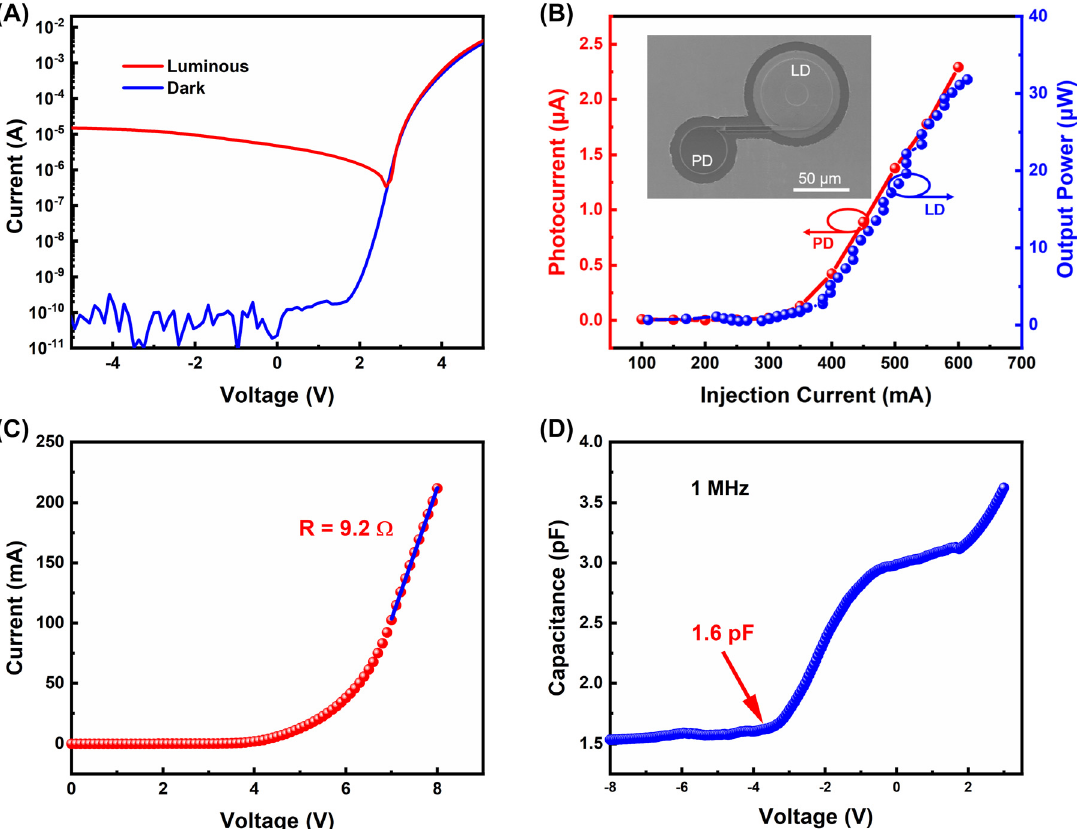
Figure 4: Characteristics of on-chip integration of the GaN-on-Si microring laser. (A) The measured I–V curves of a microdisk in dark and luminous of adjacent microring LD. (B) The induced photocurrent of a microdisk PD ( R = 20 μ m, r = 0 μ m) without Ag coating and the light output power of a LD-W-Ag ( R = 30 μ m, r = 10 μ m) as a function of the injection current at zero bias, the inset showed a bird-view SEM image of a preliminary on-chip integration of microring LD and microdisk PD directly connected by a 100 μ m-long waveguide. (C) I–V characteristics of the LD-W-Ag ( R = 30 μ m, r = 10 μ m), and (D) C–V measurement of the laser under a modulation frequency of 1